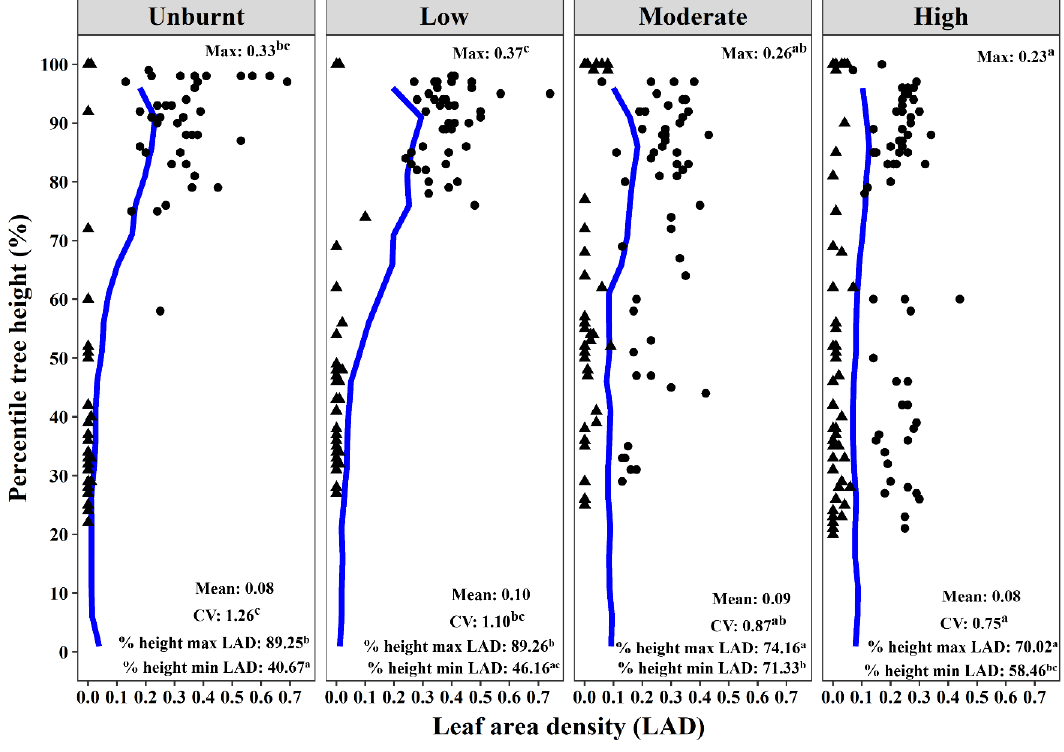
Figure 8. Comparison of LiDAR-derived metrics extracted from leaf area density (LAD) profiles of individual trees — maximum LAD (LADmax), mean LAD (LADmean), coefficient of variation of LAD (LADcv), percentile height of maximum LAD (HtmaxLAD) and percentile height of minimum LAD (HtminLAD) — among fire-severity types. The mean LAD profile (blue line), percentile height of the minimum LAD (triangles), and percentile height of the maximum LAD (circles) are based on 41 to 60 trees per severity type (UB — 41, L — 43, M — 52, H — 60, as individual filled circles and triangles). The blue line in the figure represents the mean LAD profile, triangles and circles are the minimum and maximum LAD values for individual trees, other values are the mean metrics, and superscript letters indicate pairwise comparison at p < 0.001 (LADmax), p < 0.001 (LADcv), p = 0.461 (LADmean), p = 0.003 (HtmaxLAD), and p < 0.001 (HtminLAD). P-values were calculated from LMEM, and different letters indicate significant differences between fire-severity types as indicated by post hoc tests (Fisher’s LSD